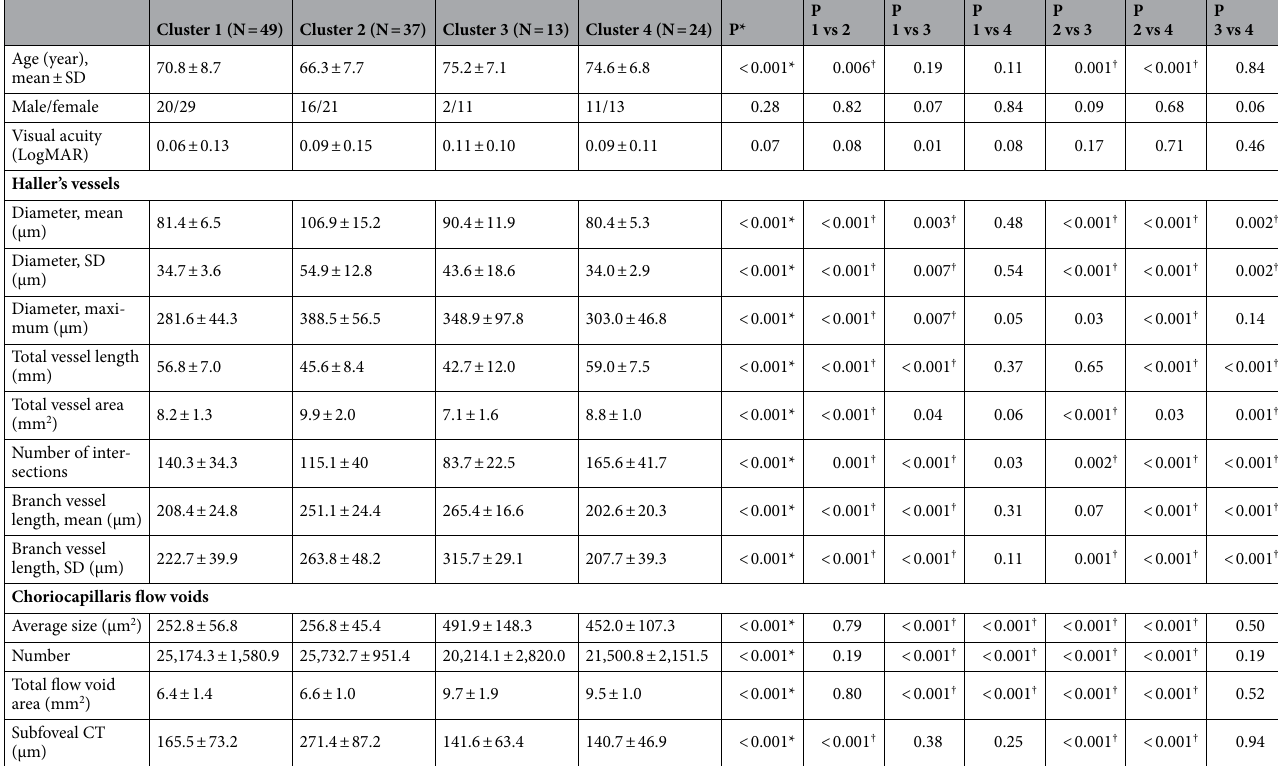
Table 3. Summary of differences in characteristics among the 4 clusters. SD standard deviation, CT choroidal thickness. *Significant difference by Kruskal–Wallis test (sex ratio was compared by chi-square test). † Significant difference by Mann–Whitney test with Bonferroni’s correction (P <